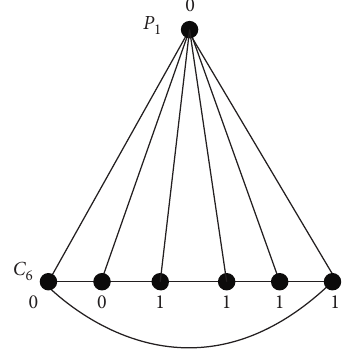
Figure 20: Logical labeling of P